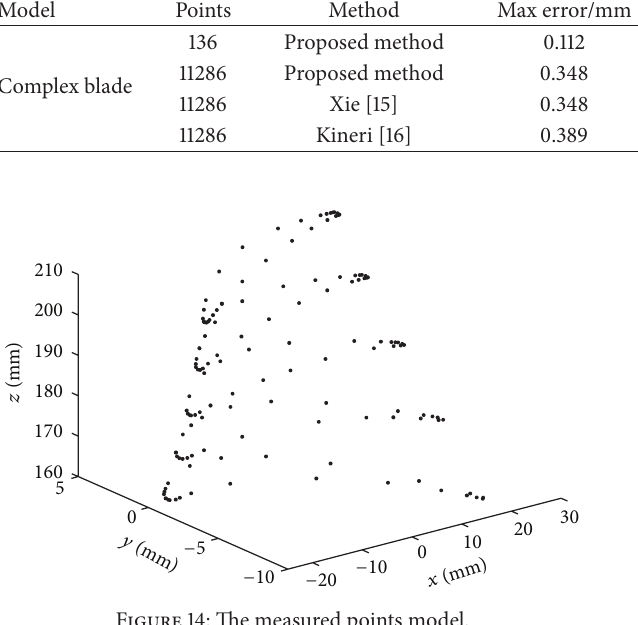
Figure 14: The measured points model.